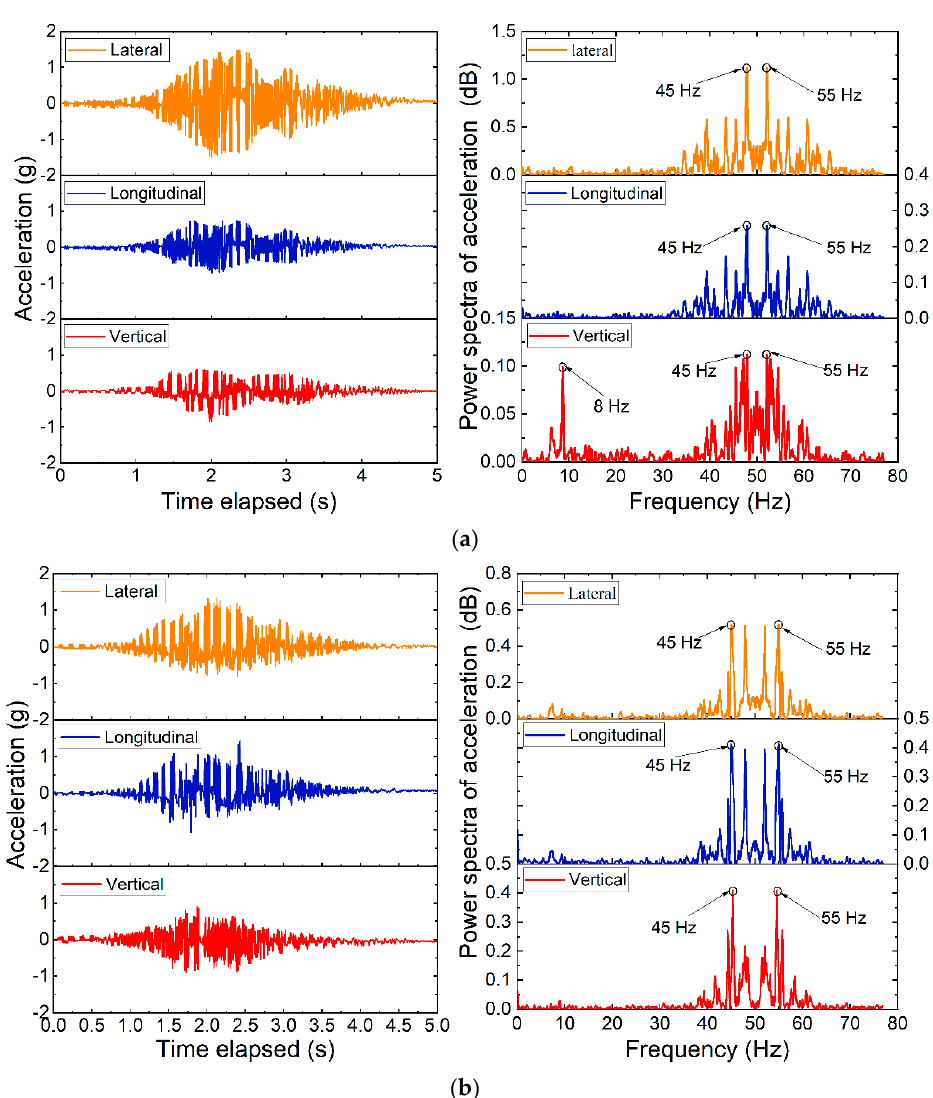
Figure 15. The time-history curves and calculated power spectra of 3D acceleration responses recorded by ( a ) #R1 and ( b ) #R2 during stabilization steps of tamping operation.